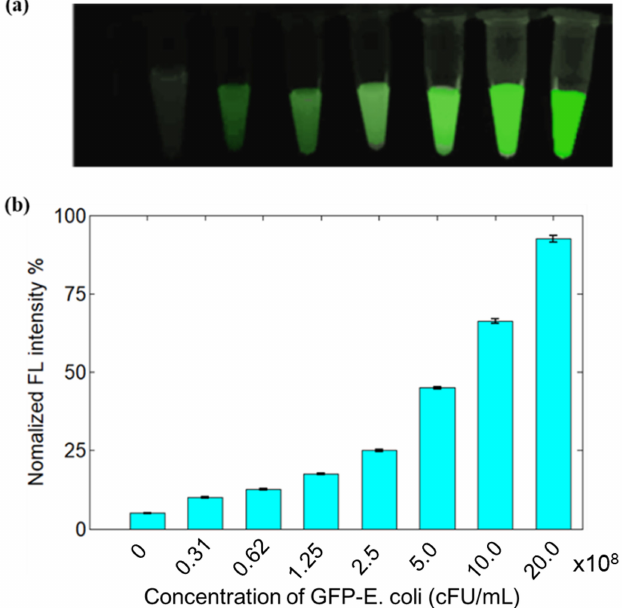
Figure 3. Fluorescence signals compared to different concentrations of green fluorescent protein (GFP)-transfected E. coli ( a ) and the relationship between the fluorescence intensity and various concentrations of GFP-transfected E. coli ( b ). cFU: Colony-Forming